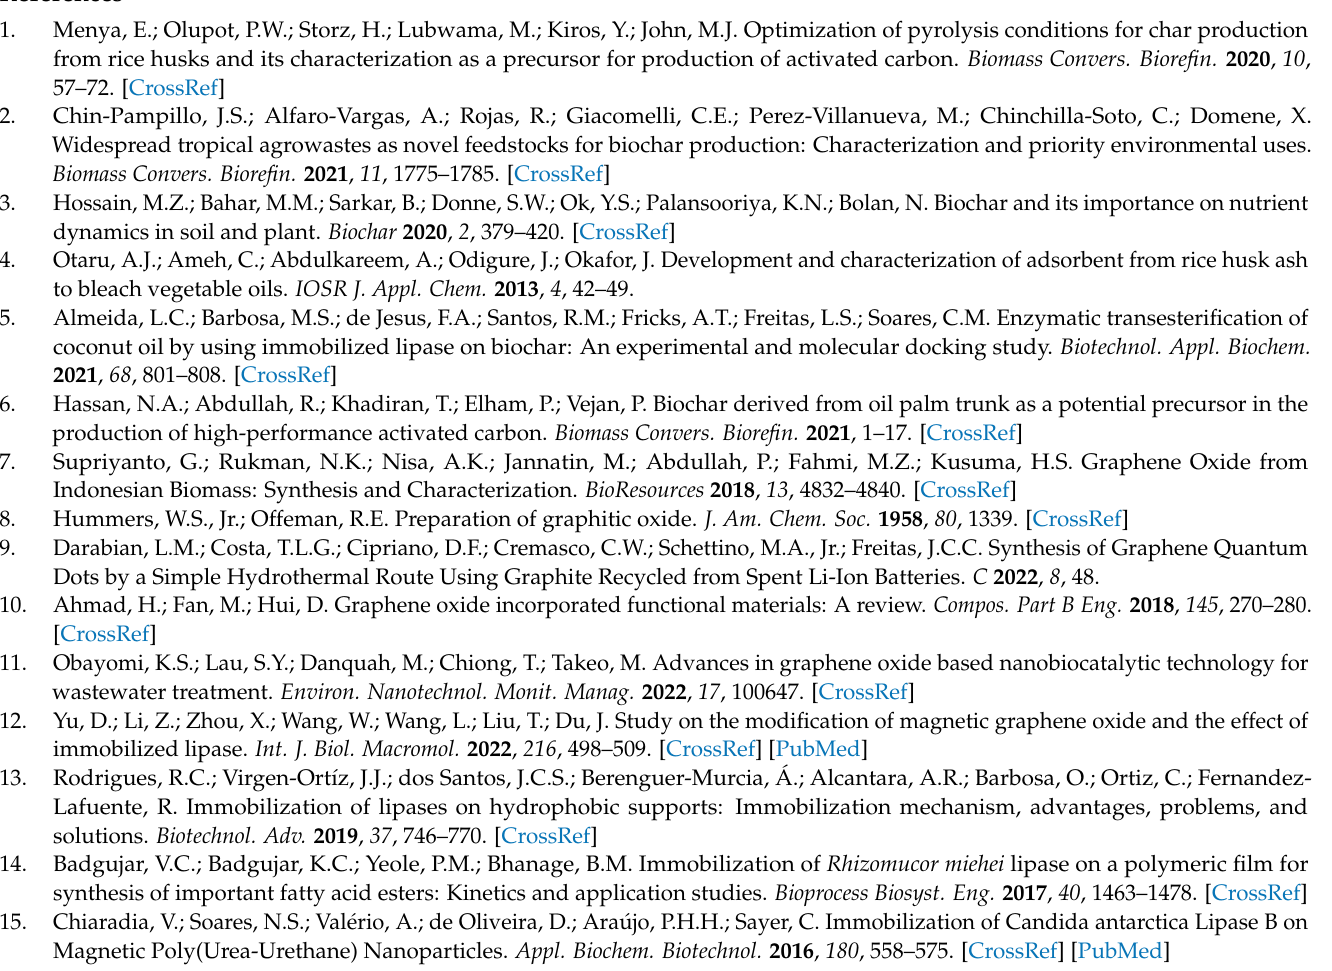
as a function of enzyme/support ratio during immobilization of the BCL on graphene; Table S4 Table S5. Temperature effect on the immobilized BCL by physical adsorption (PA) onto graphene oxide; Table S6. Thermal stability of the immobilized biocatalyst incubated at 50 ◦ C.; Table S7. Operational stability of the immobilized